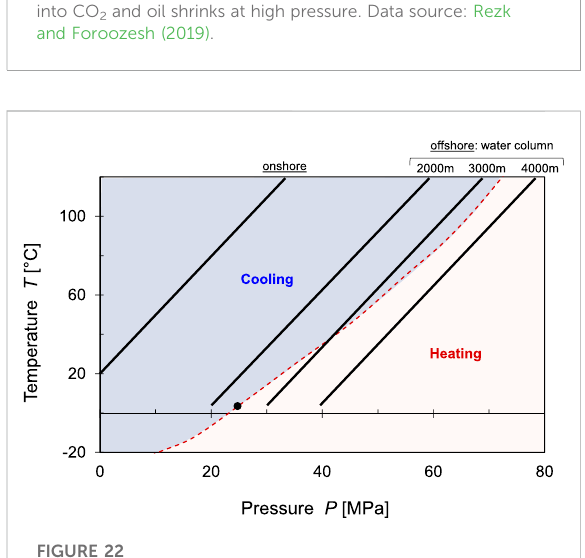
FIGURE 22 Joule-Thompson effect — Near well thermal effects. Cooling is anticipated for most onshore and offshore applications. The “ inversioncurve ” predicts heating for sea fl oorinjections beneath > 2,400 m high water